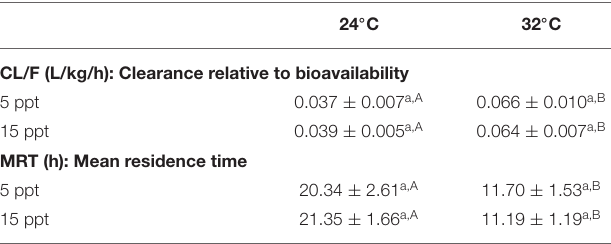
The means of half-lives are harmonic means whereas the means of the other PK parameters are arithmetic means. For each PK parameter, means with different small superscripts in each column and means with different capital superscripts in each row are significantly different from each other (p < 0.05).